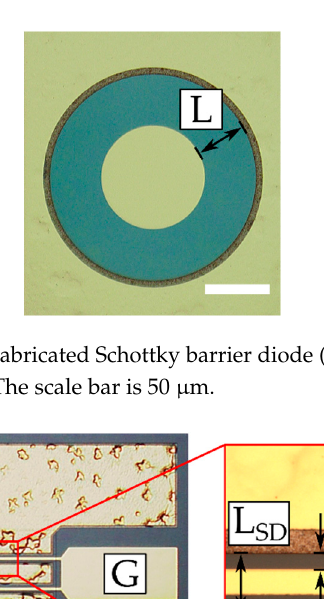
. Figure 4. Microscope image of the fabricated DC T-HEMT: the scale bar is 100 μ m. These RF T-HEMTs consisted of 200 μ m (RF T-HEMT-1) or 300 μ m (RF T-HEMT-2)-wide two- finger transistors, each of drain-source distance L SD = 14 μ m, gate length L G = 5 μ m, and gate-source distance L SG = 5 μ m. For comparison, the T-HEMTs with rectangular-type electrodes (see Figure 4), labelled here as DC T-HEMT, were also investigated (see also reference [9]). Similar to RF T-HEMTs, all DC T-HEMTs had the same gate length and gate-source distance of 5 μ m, but the channel width was of 200 μ m and the drain-source distances were 17.5 μ m, 15 μ m, and 12.5 μ m for three sample transistors labelled DC T-HEMT-1, DC T-HEMT-2, and DC T-HEMT-3, respectively. All transistors were measured on the wafer in DC and RF regimes by using Süss Microtech probe station PM8 (SUSS MicroTec SE, Garching, Germany). For the RF measurements, the G-S-G (ground– signal–ground) 150- μ m pitch high frequency probes, Agilent E8364B PNA Network Analyzer (Agilent, Santa Clara, CA, USA), and E5270B Precision IV Analyzer with IC-CAP software were used (Keysight Technologies, Santa Rosa, CA, USA). The two-step open-short de-embedding method was implemented, and small signal S-parameters were obtained. The unity current gain cut-off frequency ( f T ) and the unity maximum unilateral power gain frequency ( f max ) were found from de-embedded S- parameter frequency characteristics. The SBDs were investigated using EPS150 probe station (Cascade Microtech, Beaverton, OR, USA), high voltage source-meter Keithley 2410 (Tektronix, Beaverton, OR, USA), and impedance analyser Agilent 4294A (Agilent, Santa Clara, CA, USA). The low-frequency noise in transistors was measured in the linear regime with the source grounded. The voltage fluctuations from the drain load resistor, R L , were amplified by a low-noise amplifier and analysed using “PHOTON” spectrum analyser (Bruel & Kjaer, Nærum, Denmark). The spectral noise density of drain current fluctuations was calculated in the usual way with (